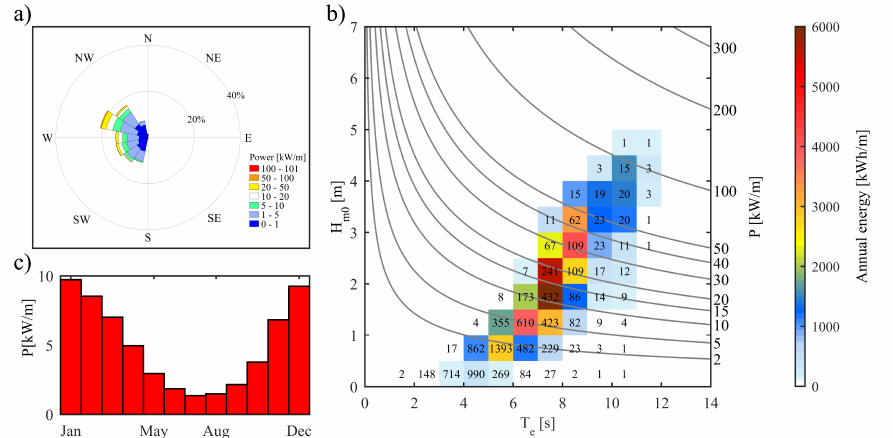
Figure 14. Characterisation of mean yearly wave energy and wave energy flux climate at point at point HT1; ( a ) the wave energy flux rose; ( b ) the scatter plot of H m energy per meter of wave front (kWh/m), the numbers within the bins indicate the occurrence of sea states (hours/year) and the isolines specify the wave energy flux; ( c ) the histograms of the monthly mean wave energy flux.